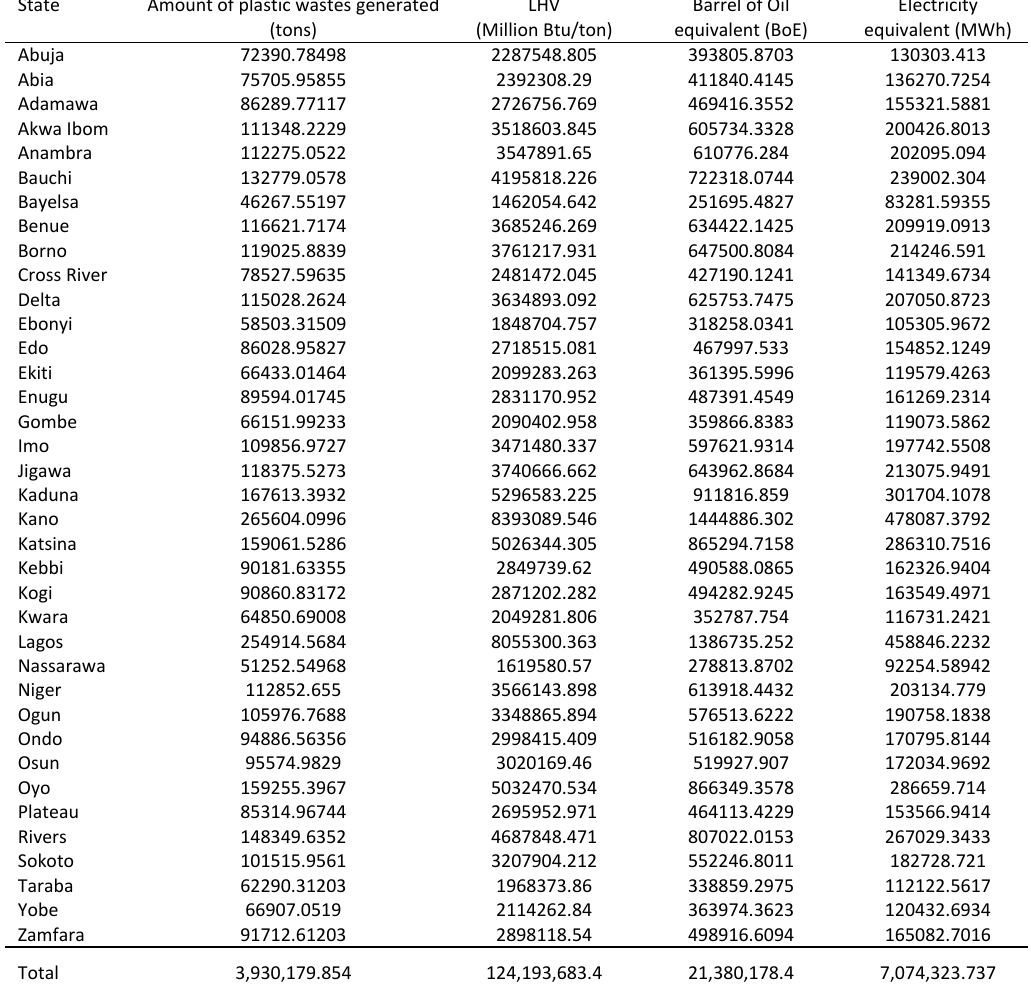
Table 5: Energy equivalent of plastic wastes generated in different States of Nigeria in 2016